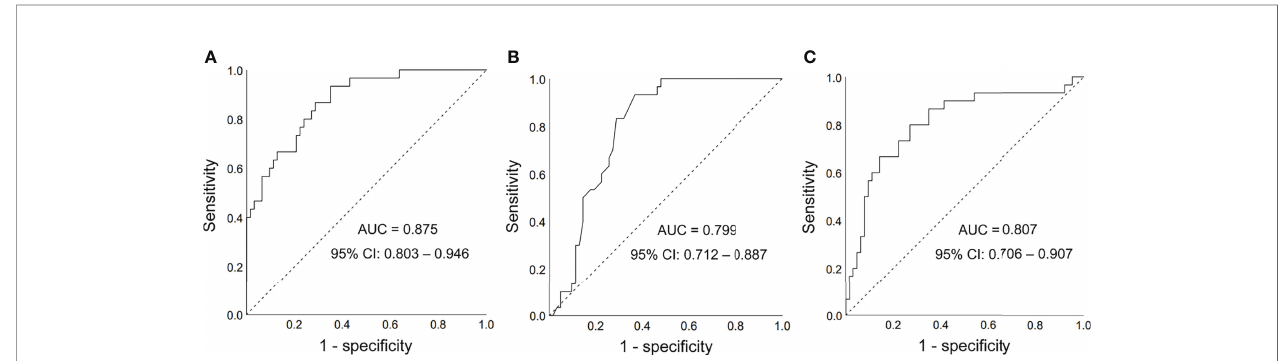
FIGURE 2 | Receiver operating characteristic (ROC) curves. (A) FGF21 for diagnosis of DMED; (B) HbA1c for diagnosis of DMED; (C) HOMA-IR for diagnosis of DMED; AUC, area under the curve; CI, con fi dence